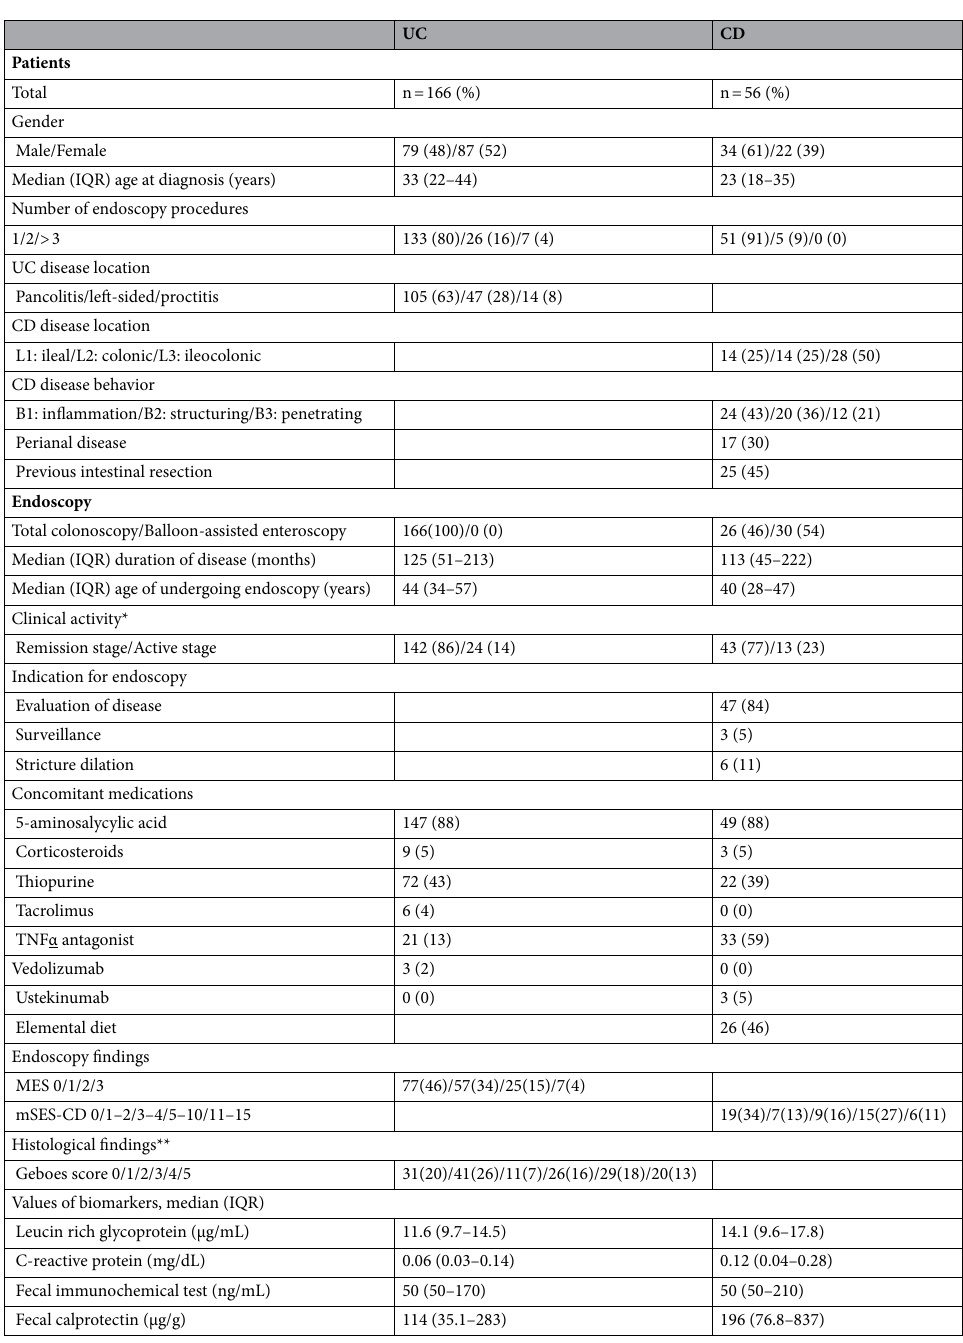
Table 1. Characteristics of the study patients, colonoscopy findings and results of serum/fecal markers. UC ulcerative colitis, CD Crohn’s disease, IQR interquartile range, MES Mayo endoscopic subscore, mSES-CD modified simple endoscopic score for Crohn’s disease. *Clinical remission was defined as a Mayo stool frequency subscore of 0 or 1 and a Mayo rectal bleeding subscore of 0 for UC, and Crohn’s disease activity index (CDAI) < 150 for CD. **Of the total 166 UC cases, 158 underwent biopsy for pathological